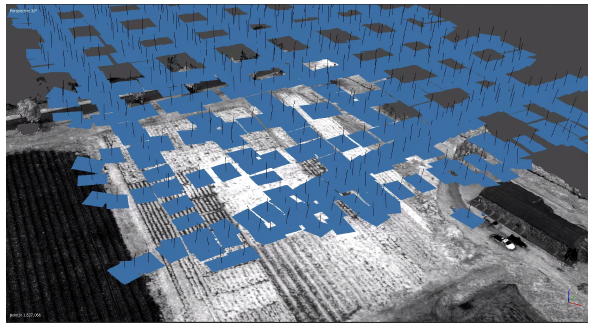
Figure 5. Photogrammetric adjustment - alignment